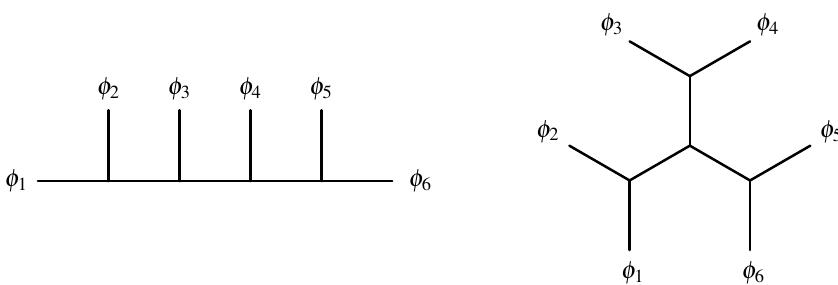
Figure 1. OPE diagrams in the comb channel (left) and snowflake channel (right) for 6-point